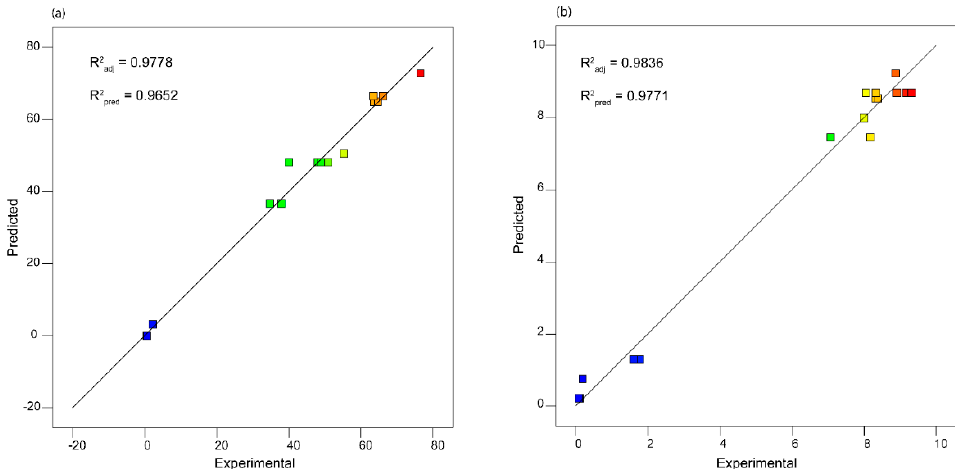
Figure 4. Comparison of the experimental results with predicted results by the model. P extraction ( a ) and Zn extraction ( b ). The points are colored on a scale according to the considered response starting from blue (minimum value) to red (maximum value).